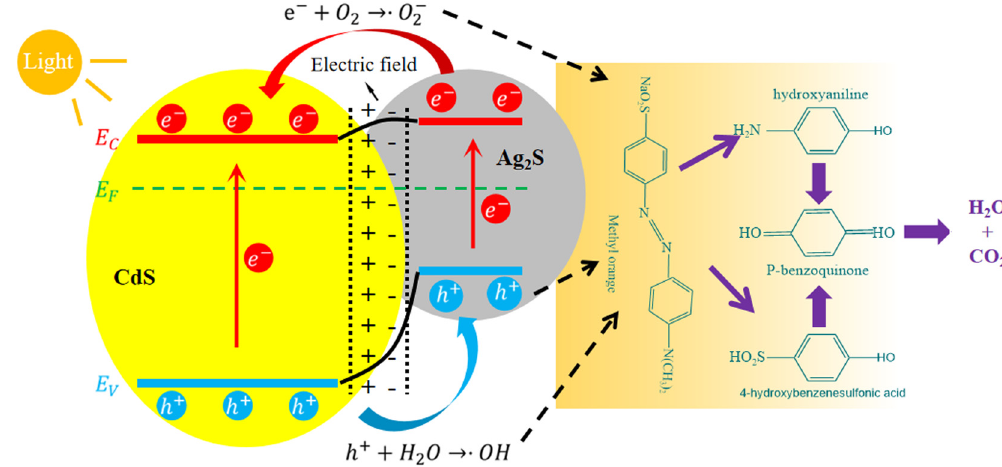
Figure 10: Degradation mechanism of MO by CdS – Ag 2 S nanocomposites under visible light